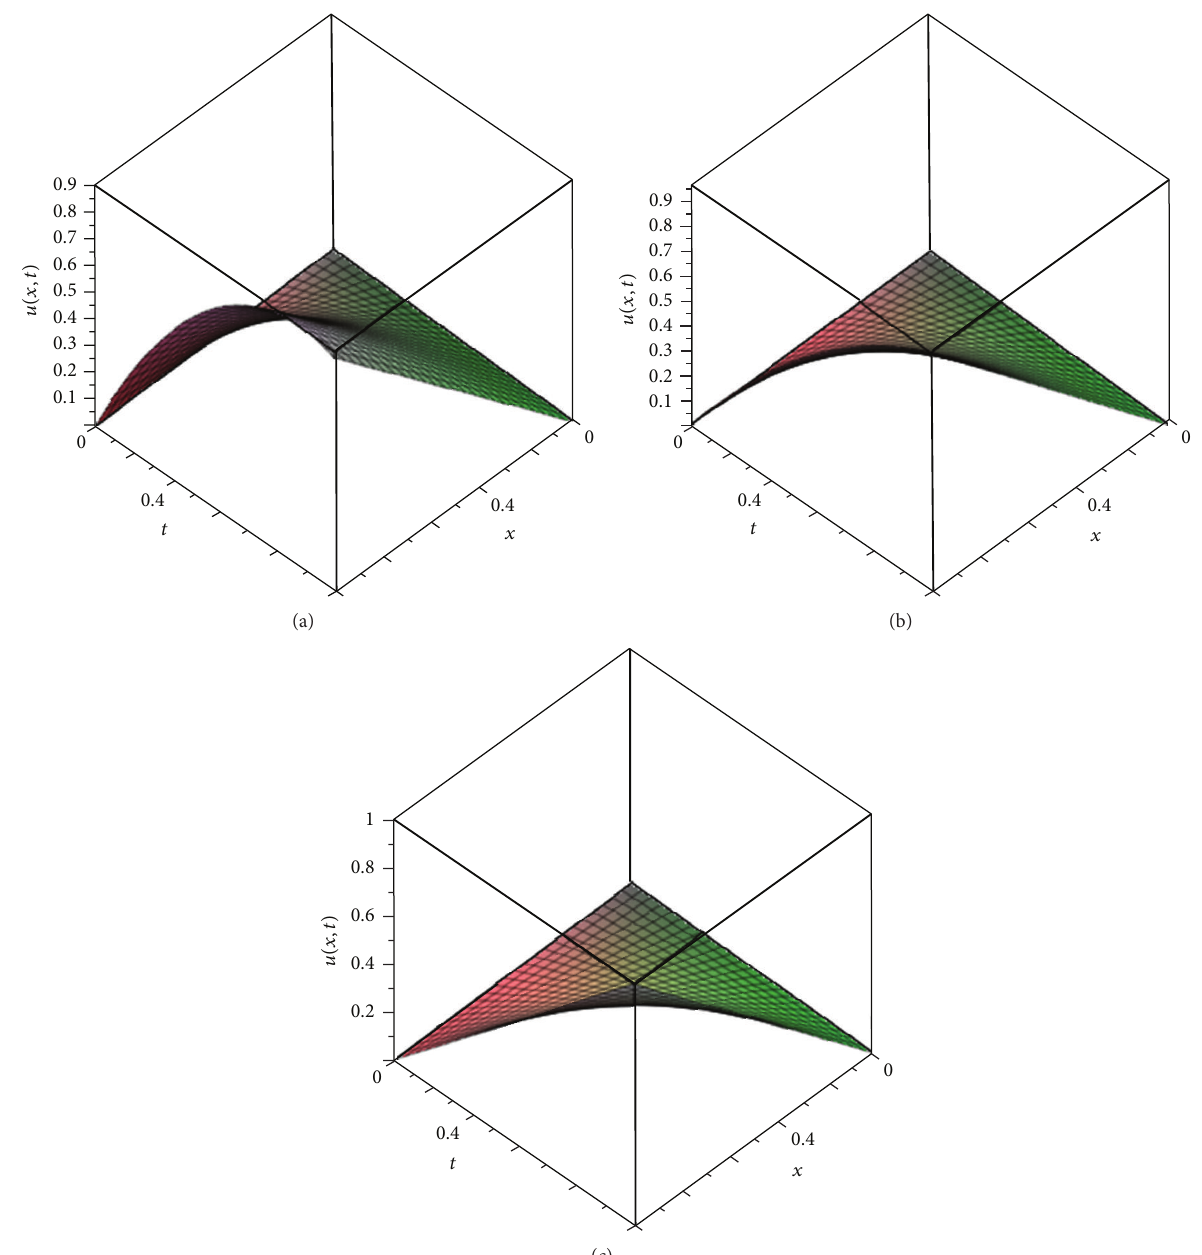
Figure 5: Plot of 𝑢(𝑥,𝑡) with respect to 𝑥 and 𝑡 at (a) 𝛼 = 0.5 , (b) 𝛼 = 0.75 , and (c) 𝛼 = 1 .